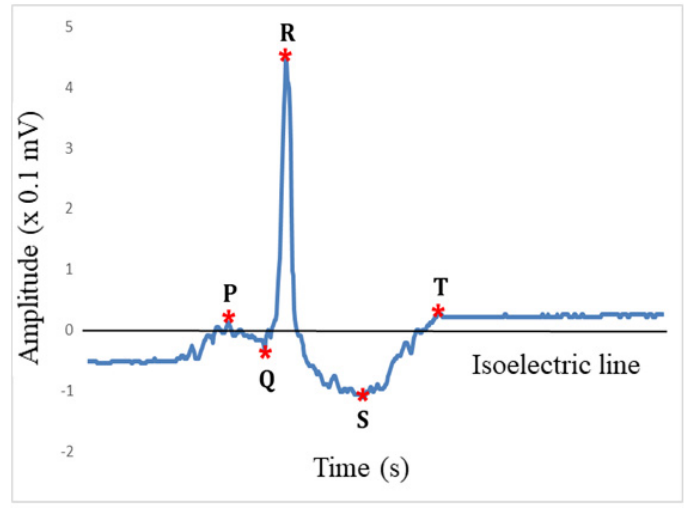
Figure 8. Extracted feature data of the ECG.